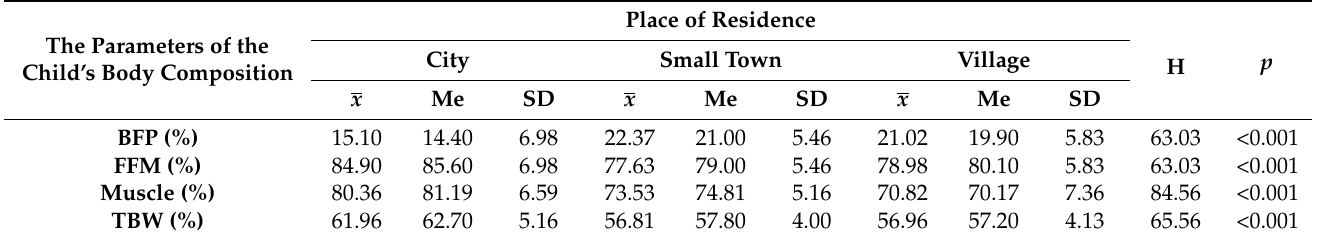
Table 4. Differences in the composition of body weight depending on the place of residence of the